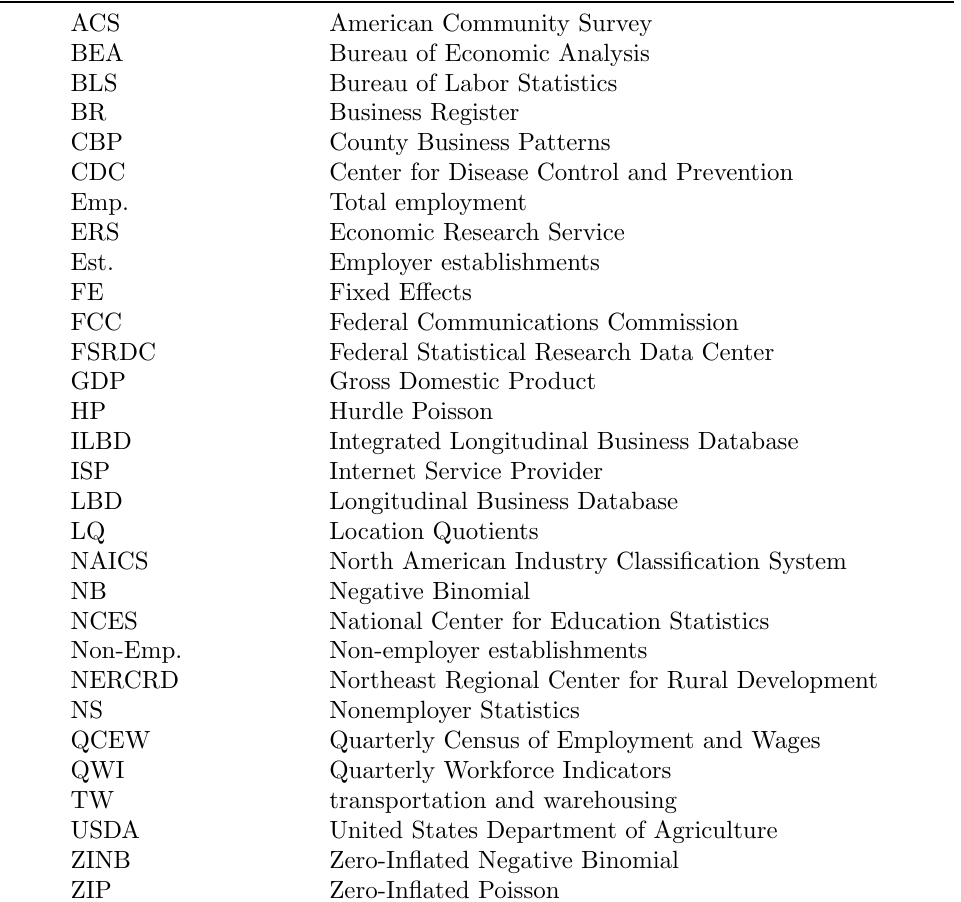
Table A.1: List of Abbreviations and Acronyms